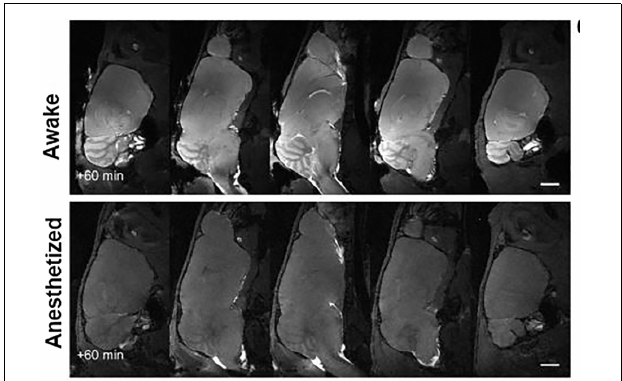
FIGURE 2 | Gadolinium-enhanced magnetic resonance imaging of the mouse brain after injection of contrast agent into the cisterna magna under awake or isoflurane general anesthesia. Adapted from Gakuba et al.